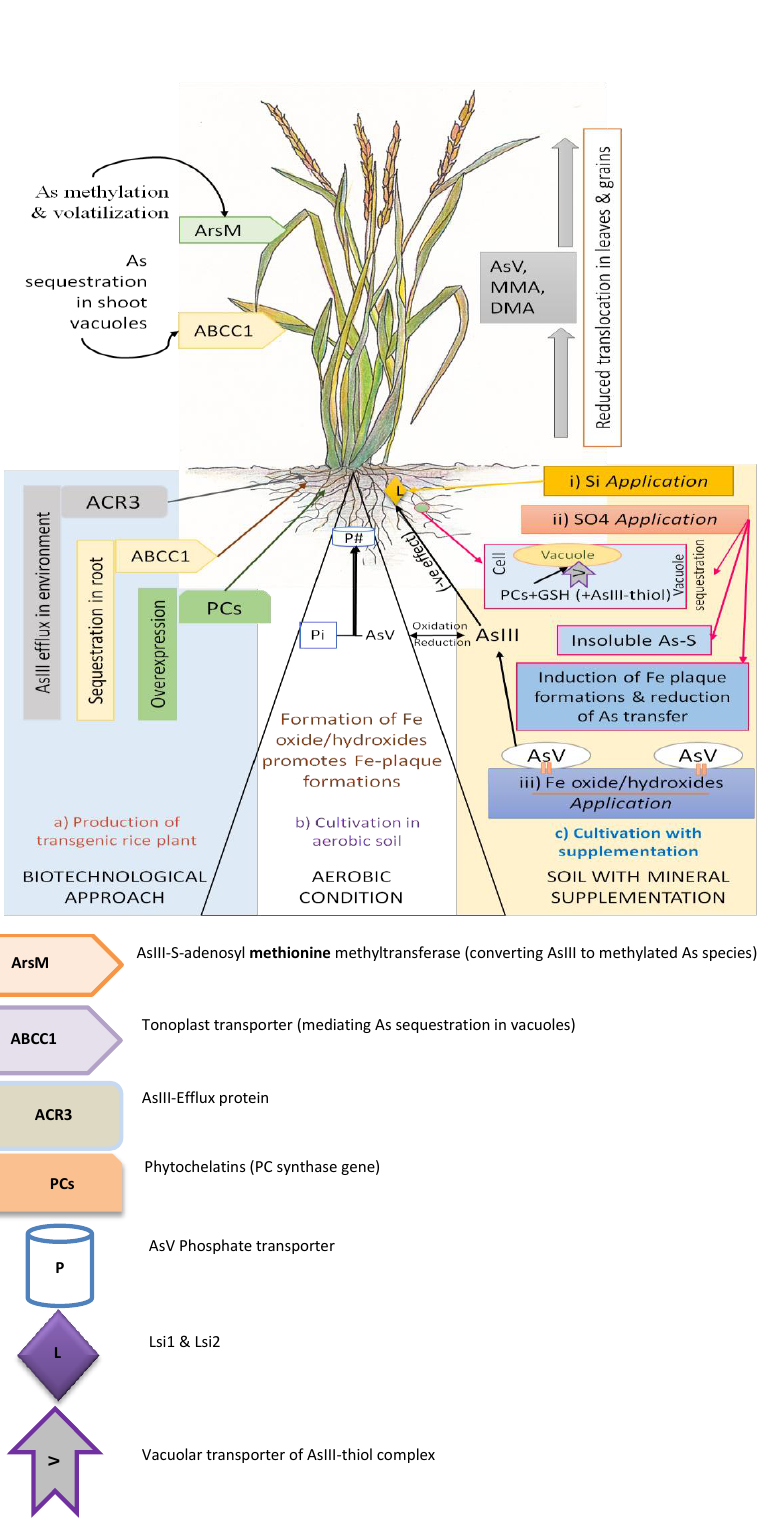
Figure 1. Schematic diagram representing the agronomic strategies and biotechnological approaches for mitigating arsenic accumulation in rice. ( a ) Production of transgenic plants to yield low arsenic-rice is the biotechnological approach, where overexpression of one or more gene(s) in plants, like, Overexpression phytochelatin synthase (PCS) gene (higher phytochelatin production in roots leads to increase arsenic-thiol complexation and decreased arsenic translocation to shoot), ABCC1 transporter protein (in roots and shoot leads to vacuolar sequestration of arsenic within roots and nodes), ACR3 gene in root cell (enhances AsIII efflux), ArsM gene (leads to arsenic methylation and volatilization)